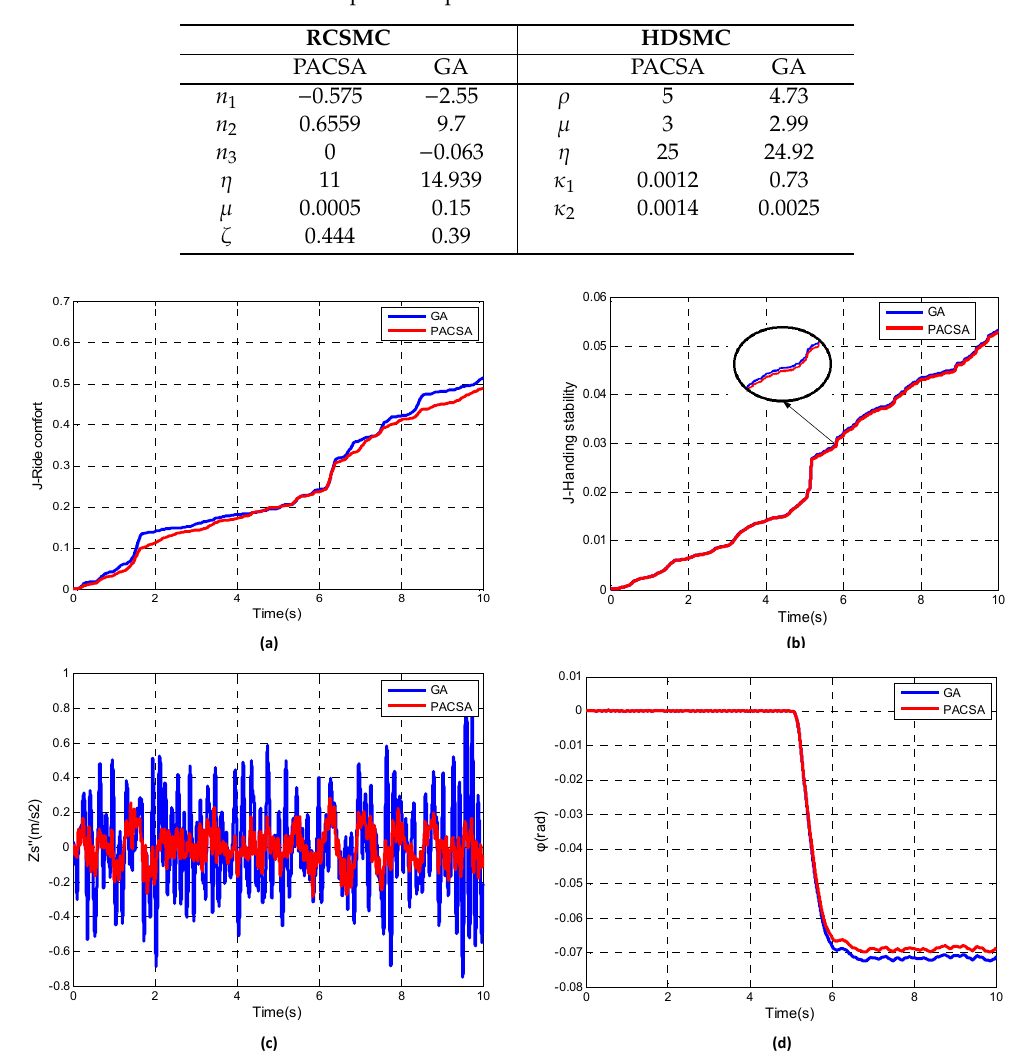
Figure 12. SMC control comparison optimized by PACSA and GA: ( a ) the objective function of ride comfort; ( b ) the objective function of handling stability; ( c ) the body vertical acceleration; ( d ) the roll angle.